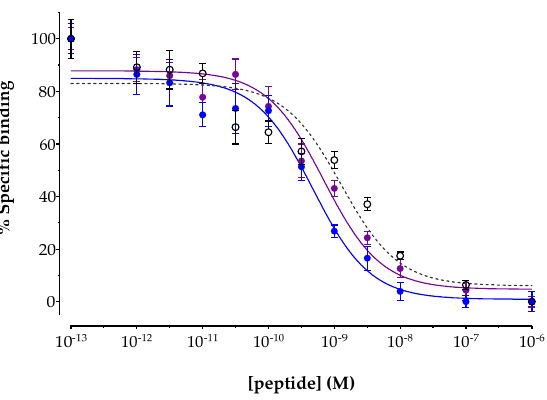
Figure 2. Displacement of [ 125 Tyr 25 ]LTT ‐ SS28 from SST 2 R binding sites in HEK293 ‐ SST 2 R cell mem ‐ branes by increasing concentrations of  AAZTA 5 ‐ LM4 (IC 50 = 1.69 ± 0.47 nM, n = 4);  [ nat In]In ‐ AAZTA 5 ‐ LM4 (IC 50 = 0.45 ± 0.05 nM, n = 3) and  [ nat Lu]Lu ‐ AAZTA 5 ‐ LM4 (IC 50 = 0.55 ± 0.38 nM, n = 3); results represent mean IC 50 values ± sd, n : number of separate experiments in triplicate.